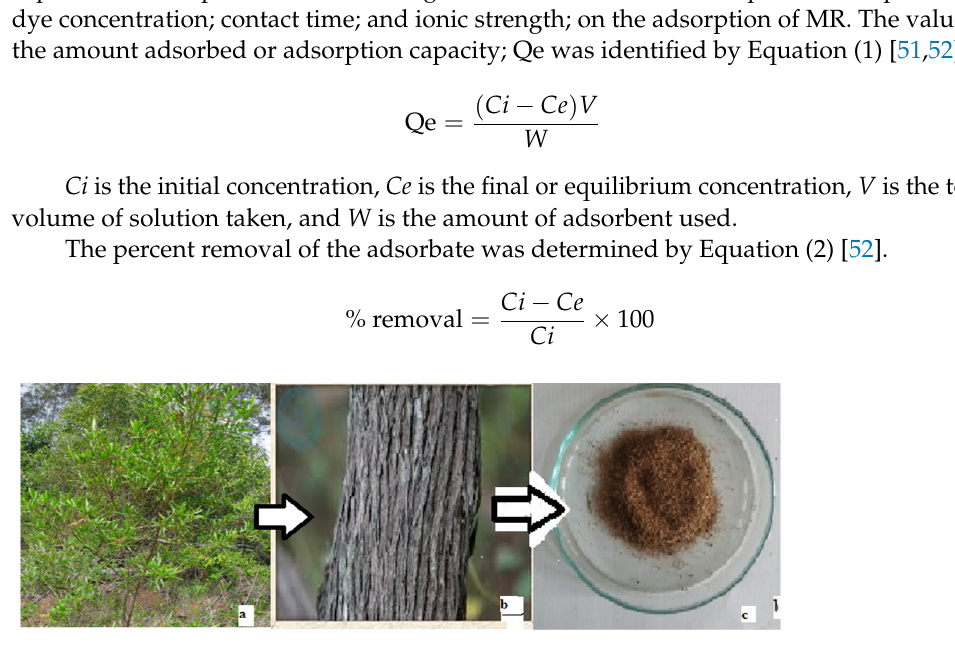
Figure 1. D. viscosa plant. ( a ) Plant ( b ) bark of plant ( c ) powdered bark. Characterizations